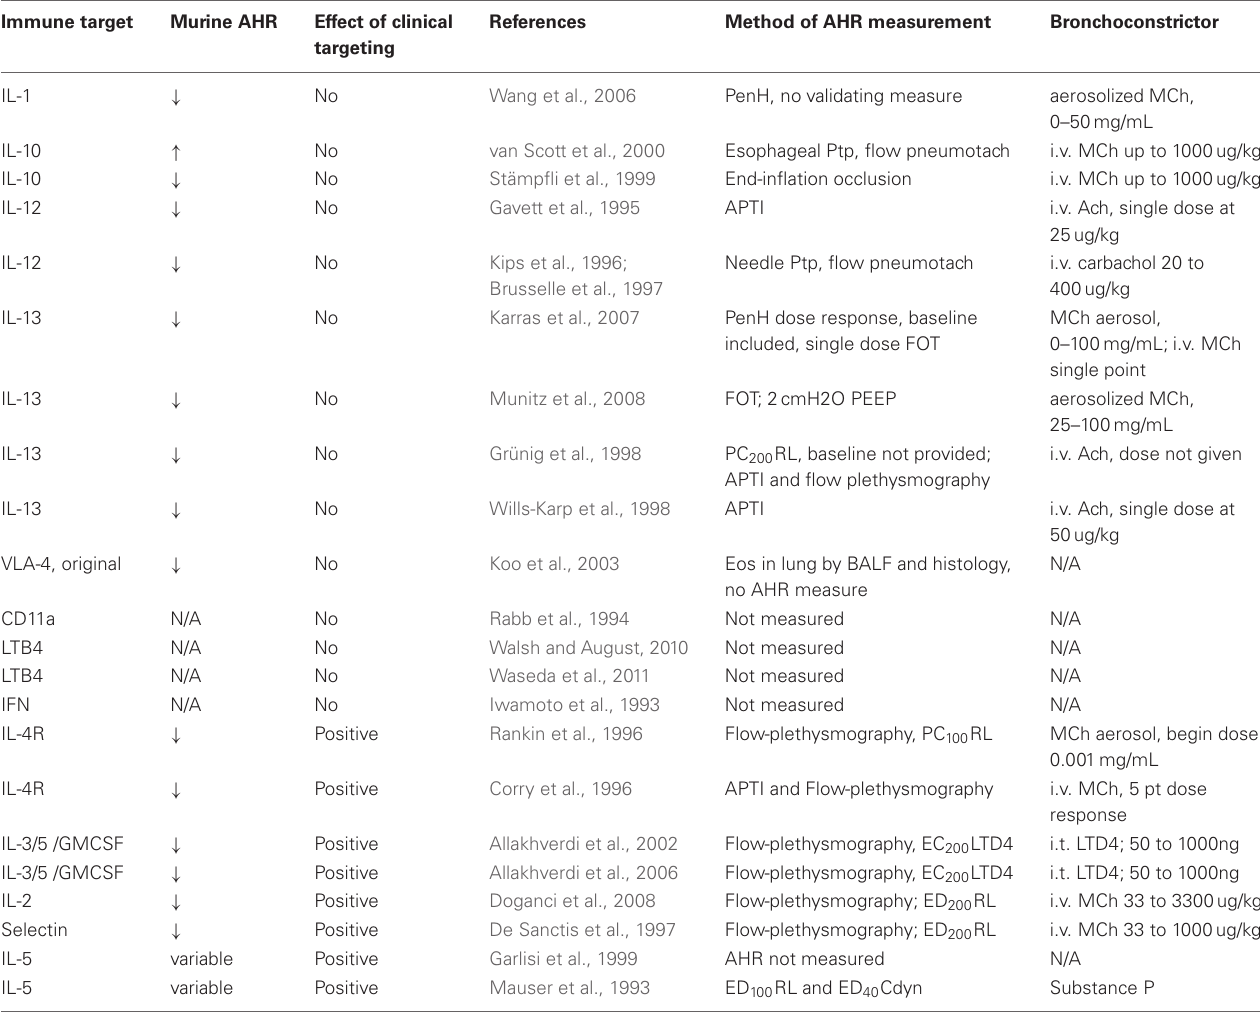
Table 1 | The impact of AHR measurement methodology on translation of immunological targets is shown below. Immune